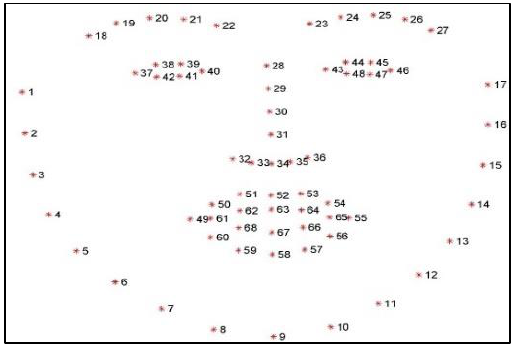
Fig. 3 . Facial landmarks that are detected by the algorithm